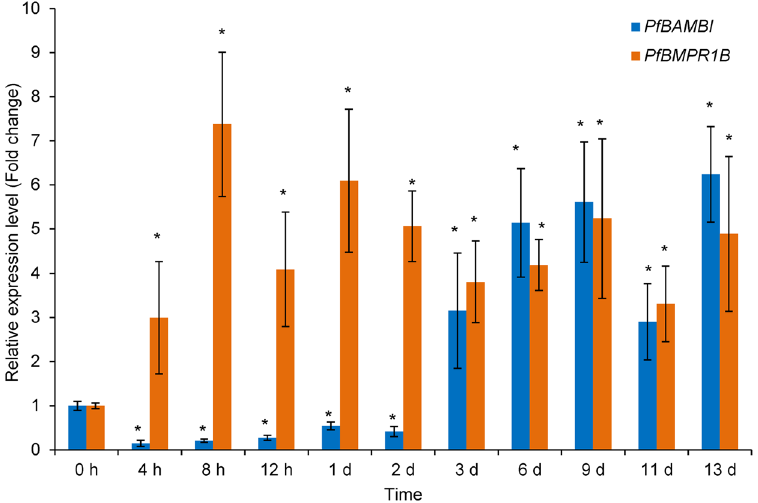
Figure 6. The relative expression levels of PfBMPR1B and PfBAMBI in the mantle of Pinctada fucata during shell notching. The expression levels of PfBMPR1B and PfBAMBI at 0 h are considered unnotched controls. * P < 0.05. Differences were assessed by one-way